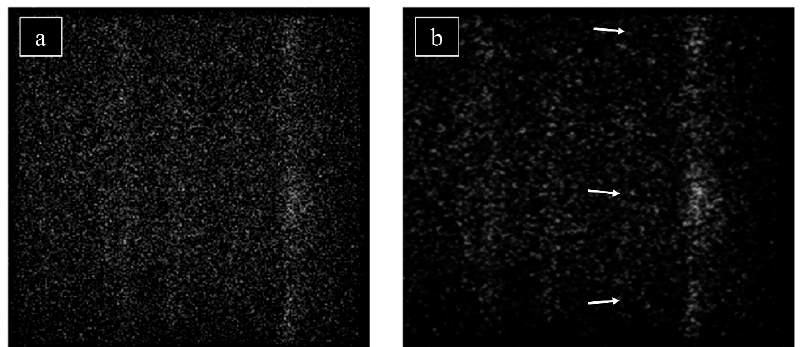
Figure 2. Neutron diffraction area detector image received from HZB before ( a ) and after ( b ) image processing. Exemplary clusters are marked using white arrows.